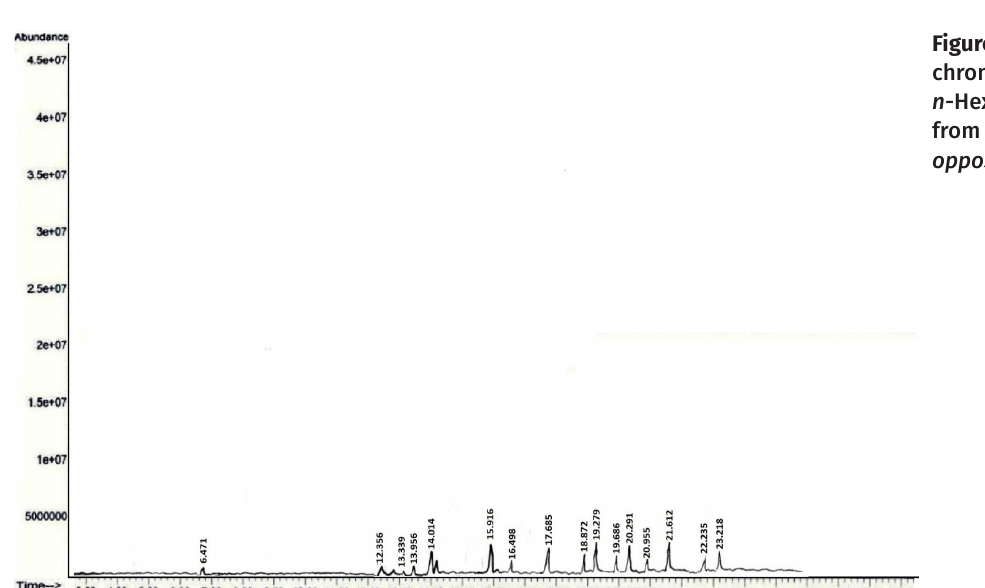
Figure 2. GC-MS chromatogram of n -Hexane extract from stem of C.